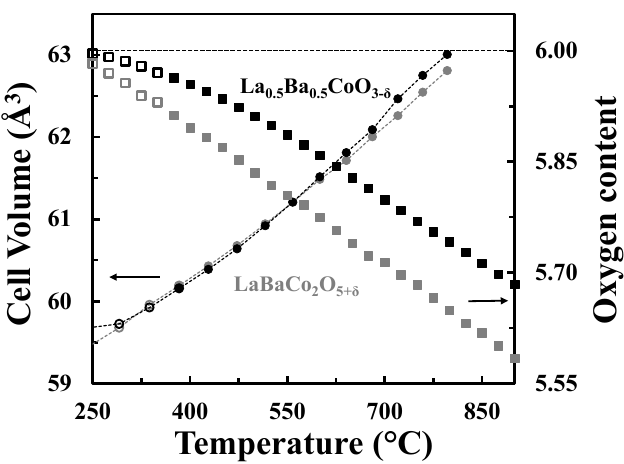
Figure 9. Cell volumes (circles) and oxygen contents (squares) versus temperature for La 0.5 Ba 0.5 CoO 3 ‐δ (black) and LaBaCo 2 O 5+ δ (grey) in O 2 . The oxygen content is with respect to the LDP. The dotted lines are guides to the eye.